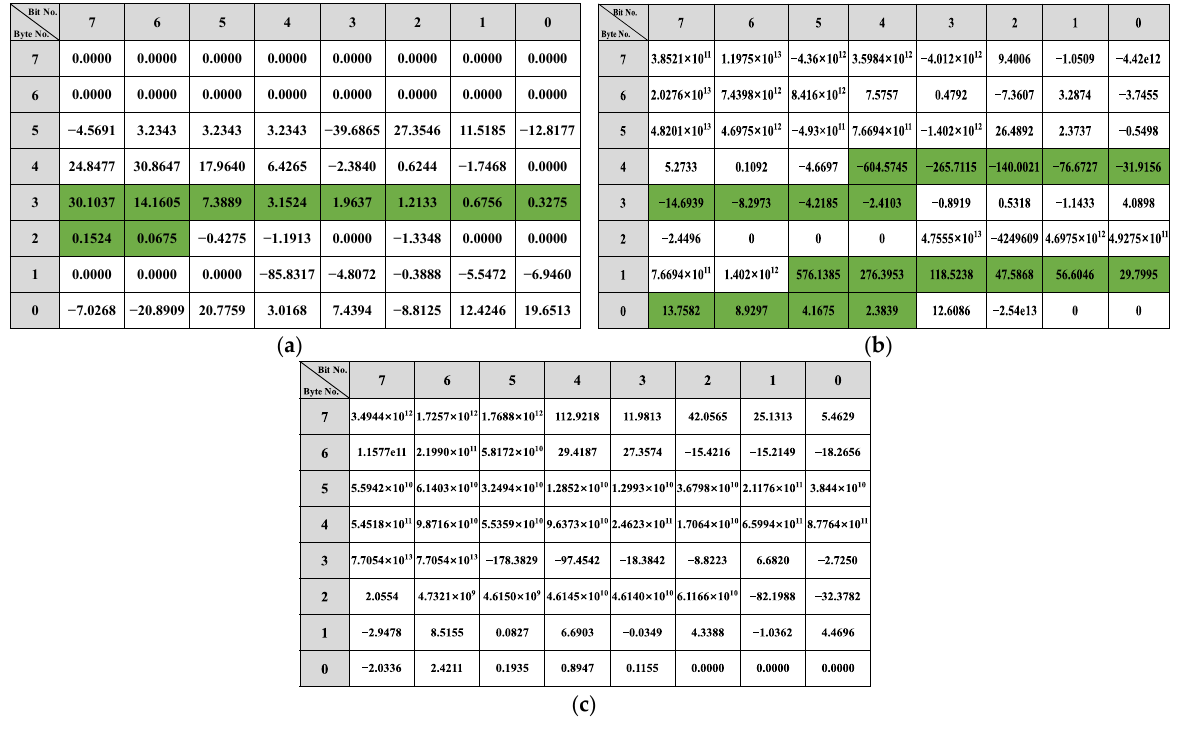
Figure 13. Steer-related messages reverse result: ( a ) ID 0x082 reverse result; ( b ) ID 0x086 reverse result; ( c ) ID 0x240 reverse result.